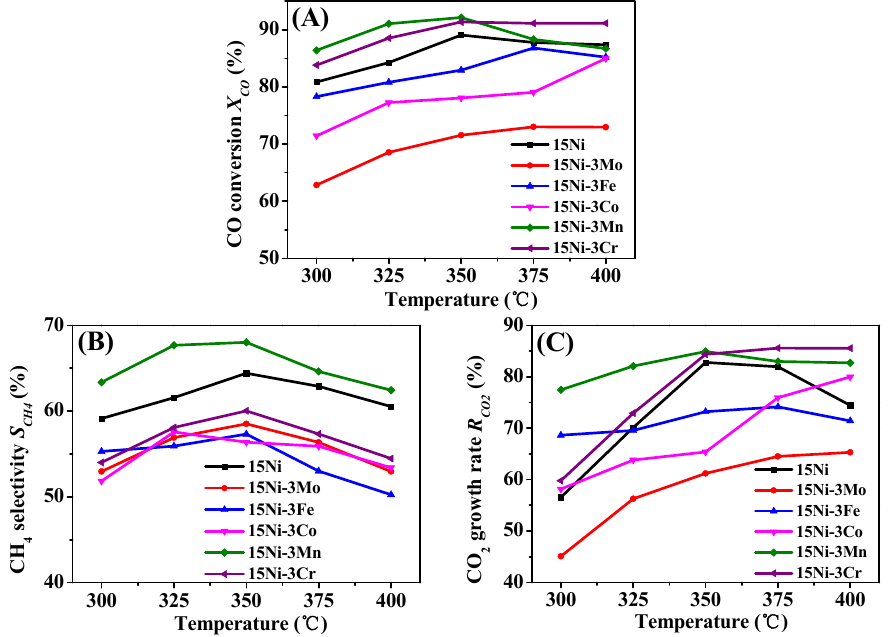
Figure 5. Catalytic performances of the reduced catalysts for partial methanation coupling with WGS at H 2 /CO = 0.8 and H 2 O/CO = 1: ( A ) CO conversion; ( B ) CH 4 selectivity; and ( C ) CO 2 growth rate.